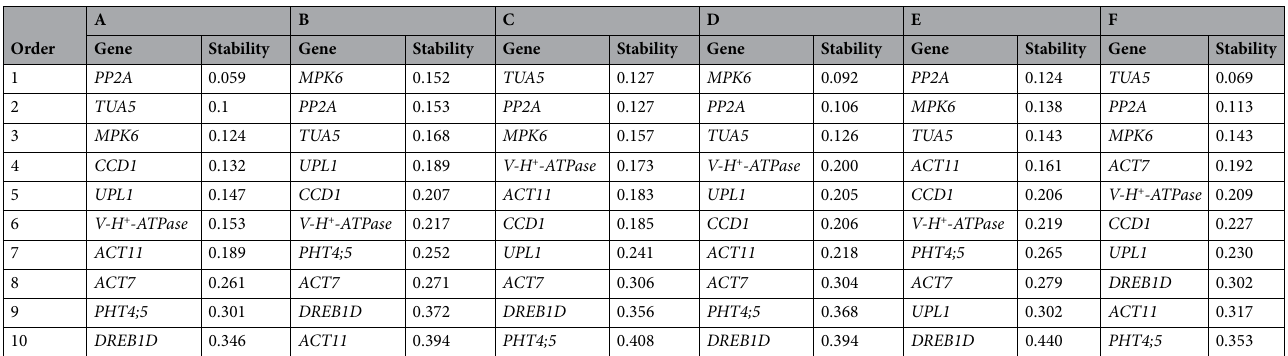
Table 2. Stability assessment of all candidate reference genes of S. glauca plants’ response to salinity stresses calculated using the NormFinder algorithms. A: Thirteen tissue samples derived from 1/10 MS liquid medium treatment. B: Thirteen tissue samples derived from 100 mM NaCl treatment. C: Thirteen tissue samples derived from 300 mM NaCl treatment. D: Fifteen germinating seed samples derived from NaCl gradient treatment. E: Eighteen seedling samples derived from NaCl gradient treatment. F: All 72 samples used in this